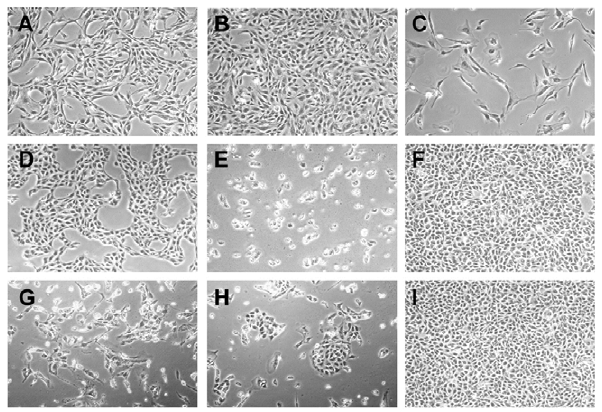
Figure 2. Characteristics and culture results of mesenchymal stem cells (MSCs) and 143B r 0 cells. (A) MSCs in DMEM had a fibroblast-like appearance. (B) MSCs survived in uridine-free media, (C) but they were sensitive to BrdU. (D) The 143B r 0 cells in permissive media supplemented with uridine had an epithelial cell-like appear- ance. (E) The 143B r 0 cells could not survive in uridine-free media, (F) but they were resistant to BrdU treatment. (G) At day 4 of Stage II coculture in uridine 2 BrdU + media, fibroblast-like MSCs could not proliferate and gradually died with a senescent appearance. (H) After 7 , 10 days in the uridine 2 BrdU + media, we observed multiple foci of colonizing cells, which had distinct epithelial-like morphology of 143B cells on microscopic examination; (I) thereafter, they grew exponentially to reach confluence. All are magnified at 6 40.